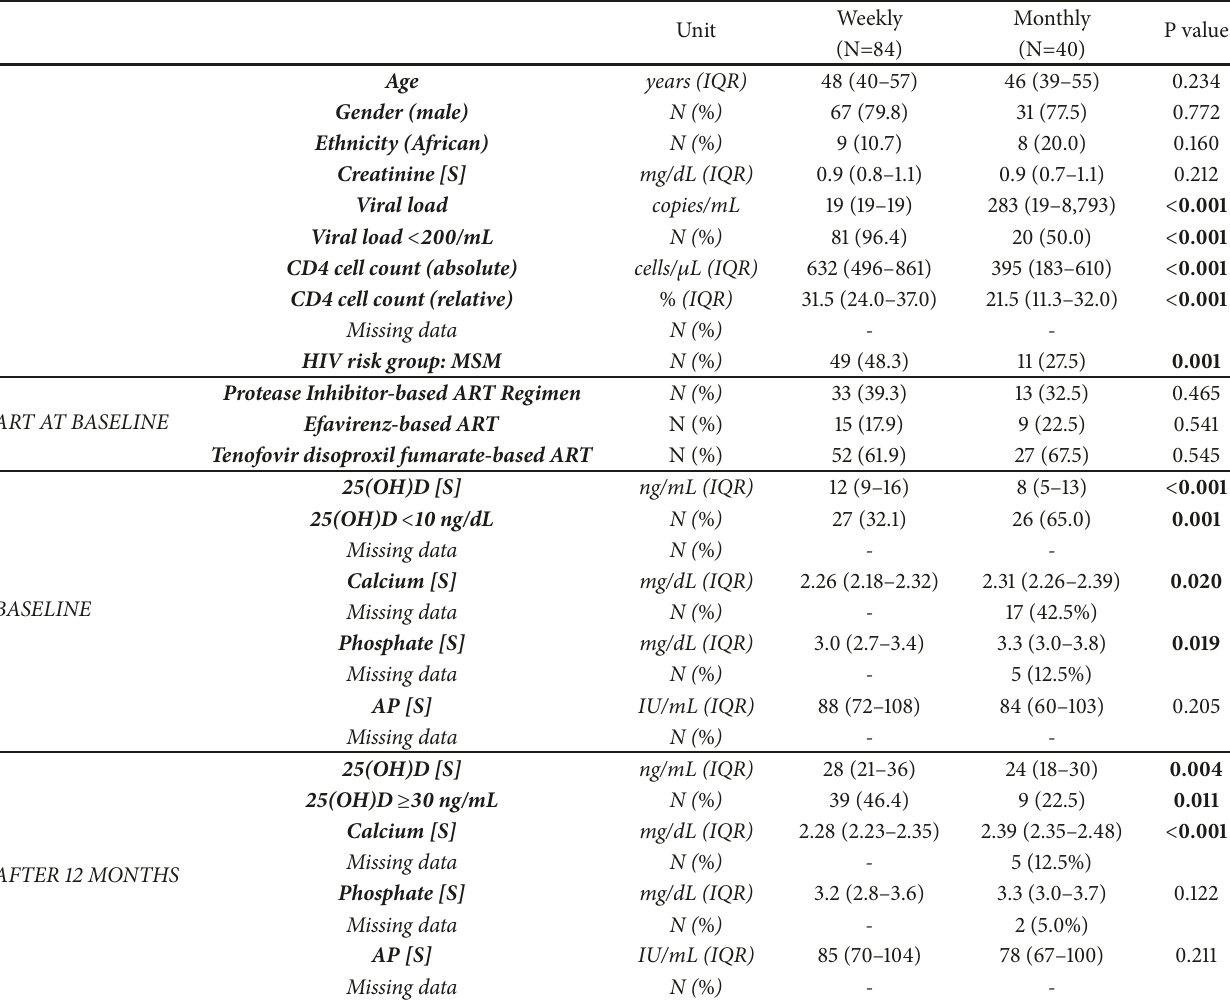
Table 1: Characteristics of the subgroup per supplementation regimen at baseline and after 12 months of supplementation ([S] = serum